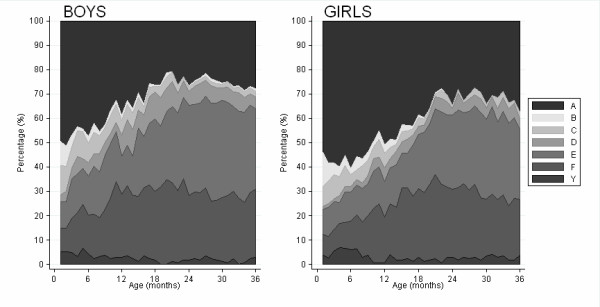
Distribution of growth faltering categories over the first three years of life. Key- A: Not malnourished, B: Wasted only, C: Wasted and underweight, D: Wasted, stunted and underweight, E: Stunted and underweight, F: Stunted only, Y: Underweight only.